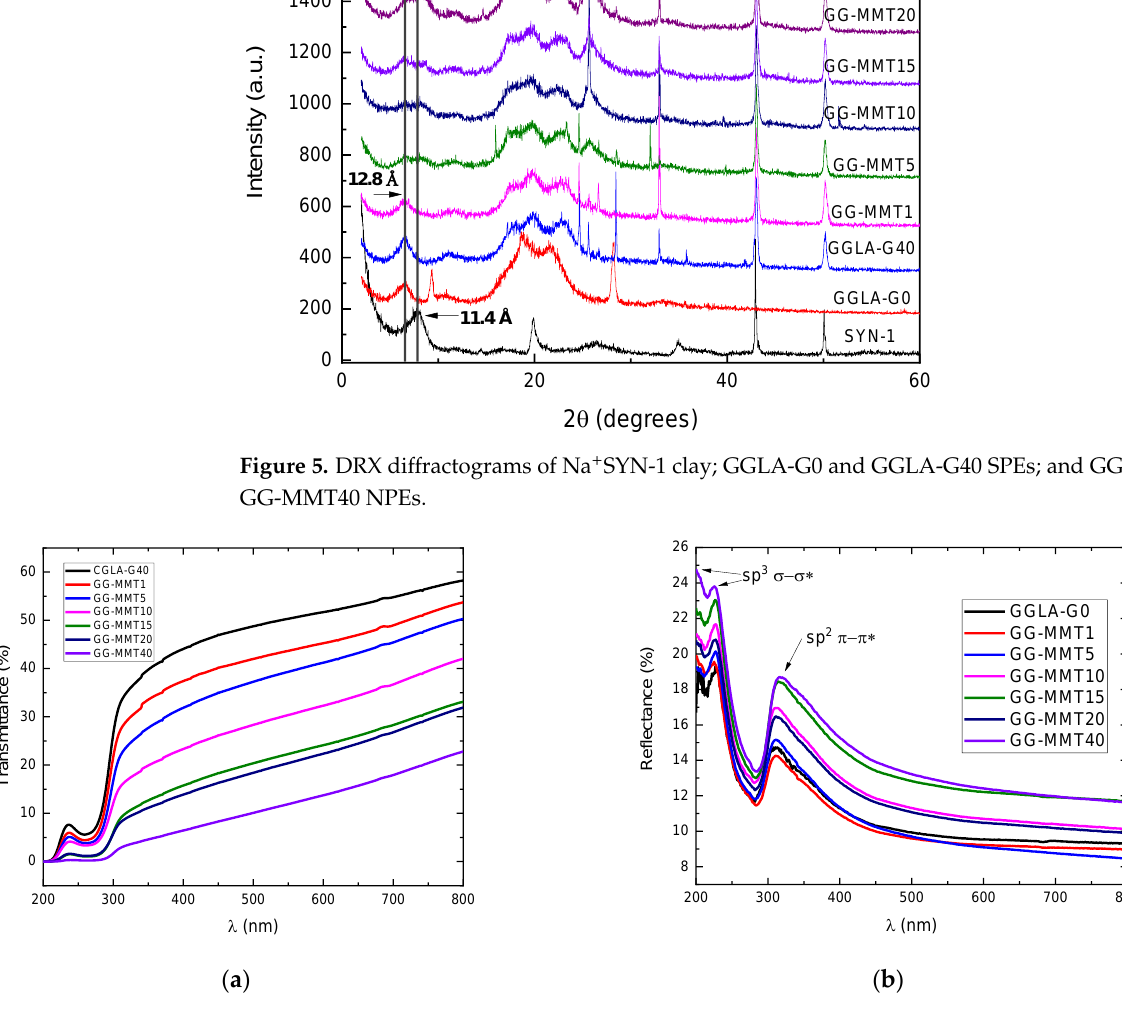
Figure 6. Optical transmittance ( a ) and reflectance ( b ) as a function of wavelength of GGLA SPEs and NPEs.